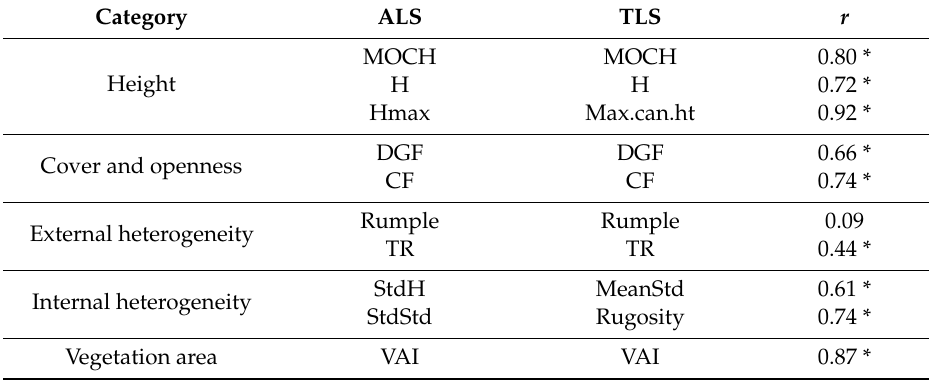
Table 4. Spearman correlations between equivalently estimated structural diversity metrics with terrestrial laser scanning (TLS) and aerial laser scanning